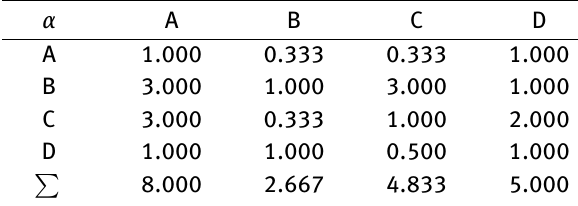
Table 2: Comparison of importance of each